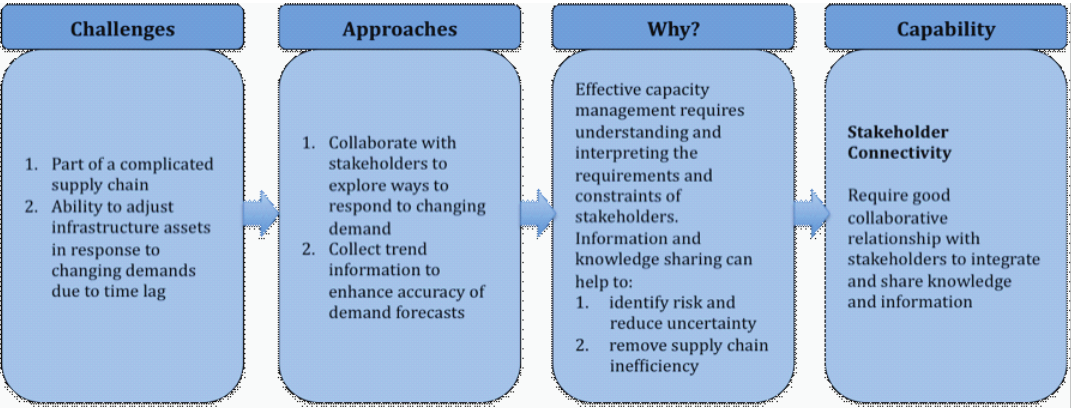
figure 1. Capability for the capacity management